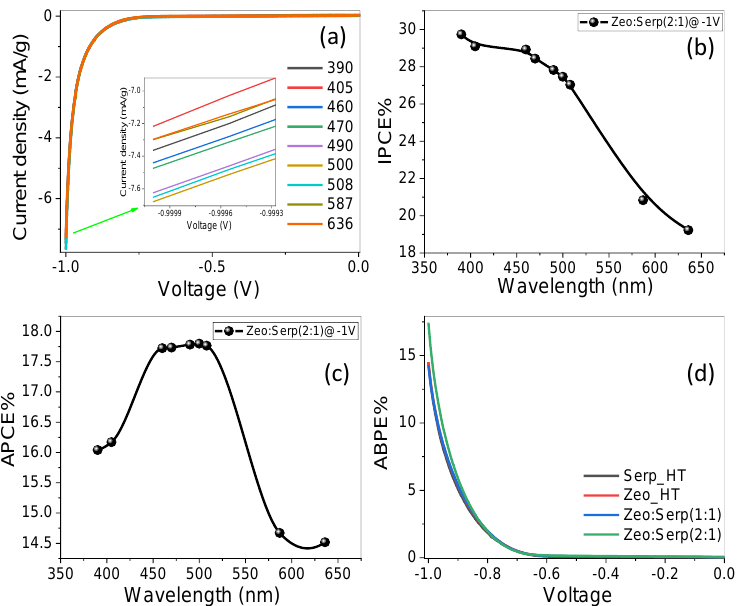
Figure 8. Zeo/Serp(2:1) photocatalyst. ( a ) Variation of Current density vs. the applied voltage under monochromatic luminance, ( b ) IPCE % and ( c ) ABCE % (Wavelength) at − 1 V vs. incident wavelength, and ( d ) ABPE % as a function of applied potential.